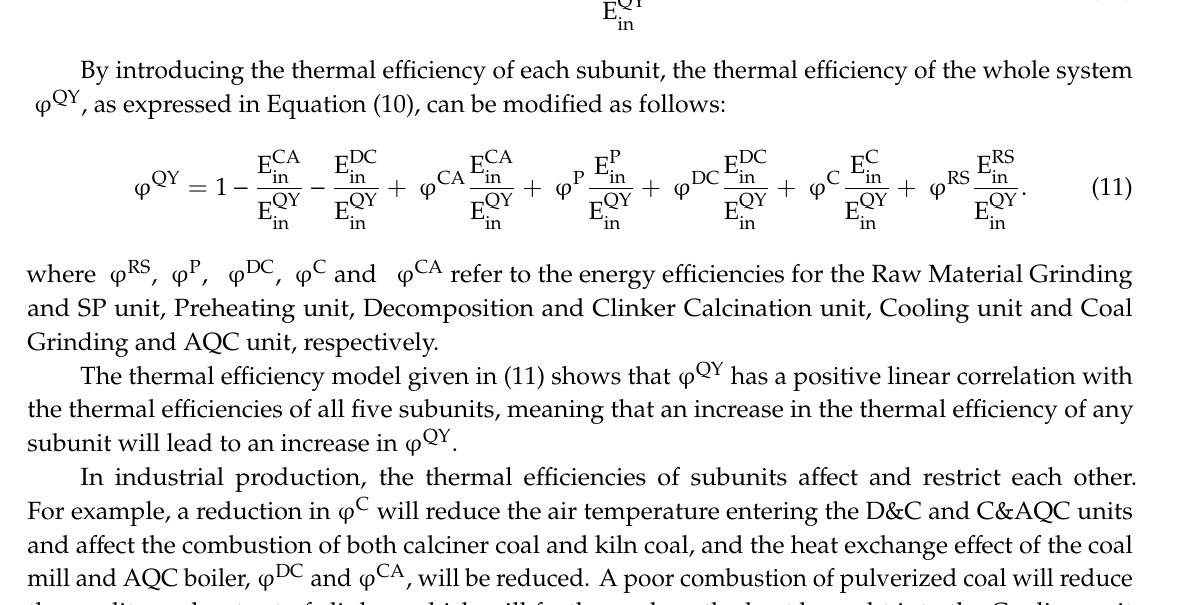
Table 3. Thermal efficiencies of subunits of a representative 5000 MT/D production line.